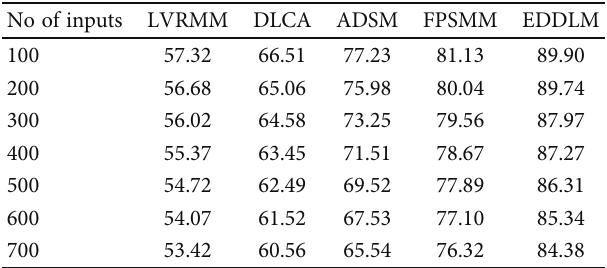
Table 3: Climate change management.